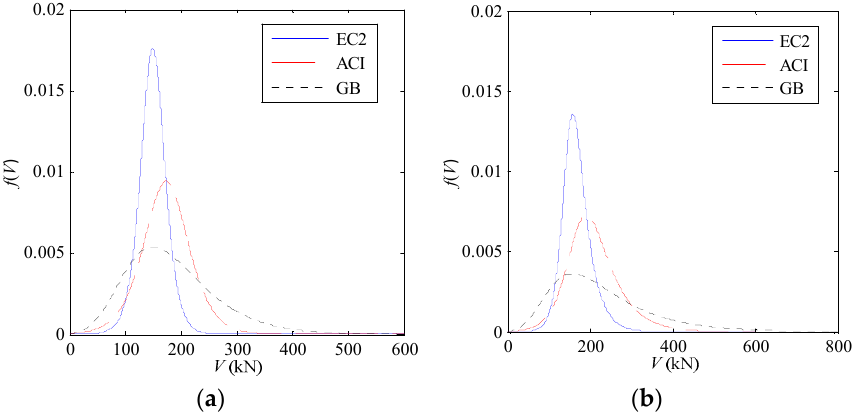
Figure 7. Comparison of the PDFs of shear capacity by different models. ( a ) PDFs of V b . ( b ) PDFs of V s .